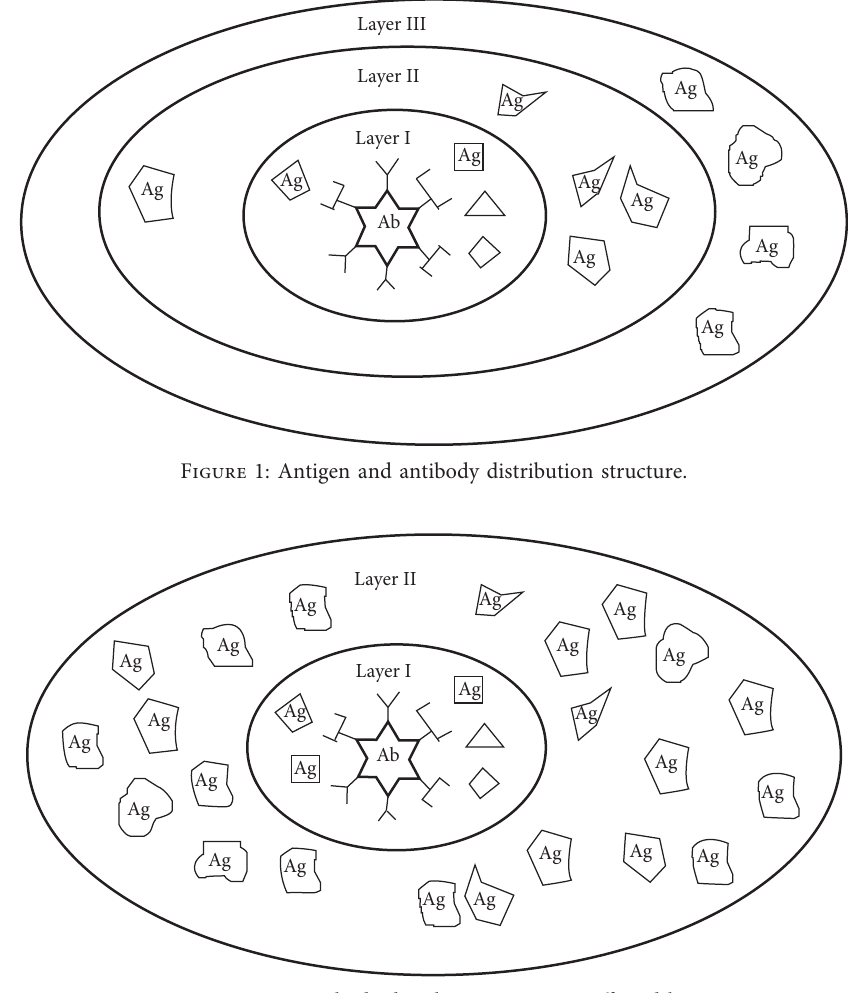
Figure 2: Antigen-antibody distribution structure affected by